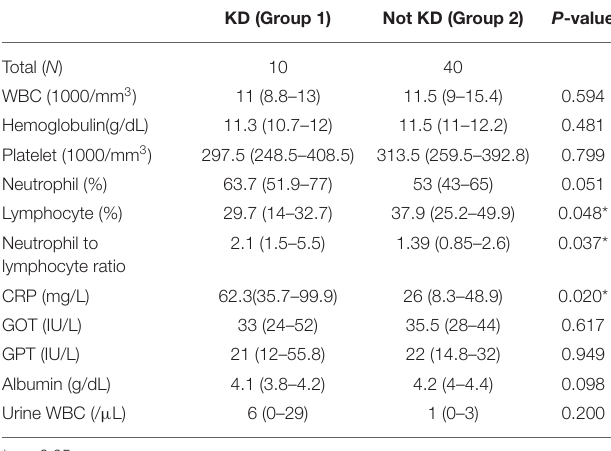
TABLE 2-1 | Patients’ laboratory data [median (IQR)] at first visit.